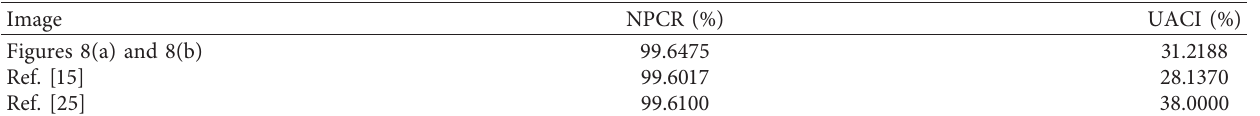
Table 5: NPCR and